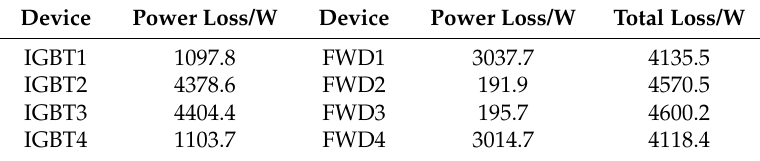
Table 5. Average Power Losses Calculated in The IGBT Modules.